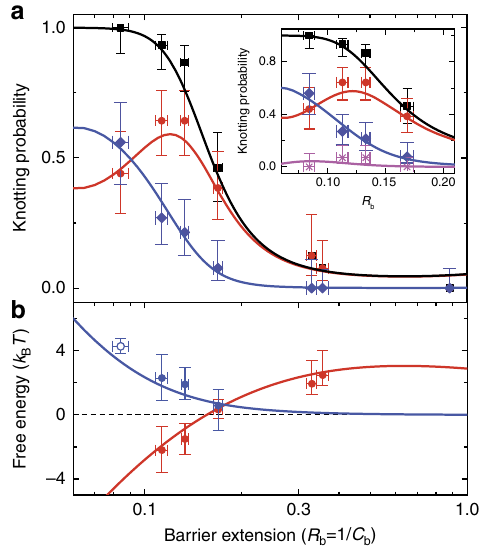
experimental data. Values of P 0 on the horizontal axis are calculated from the observed total knotting probability P 0 = 1 − P total for different values of R b . Higher values of P 0 in Fig. 5 correspond to lower compression. The Poisson model describes the data well when the molecules are only slightly compressed and P 0 is close to unity. However, for high compression ( P 0 < 0.2)